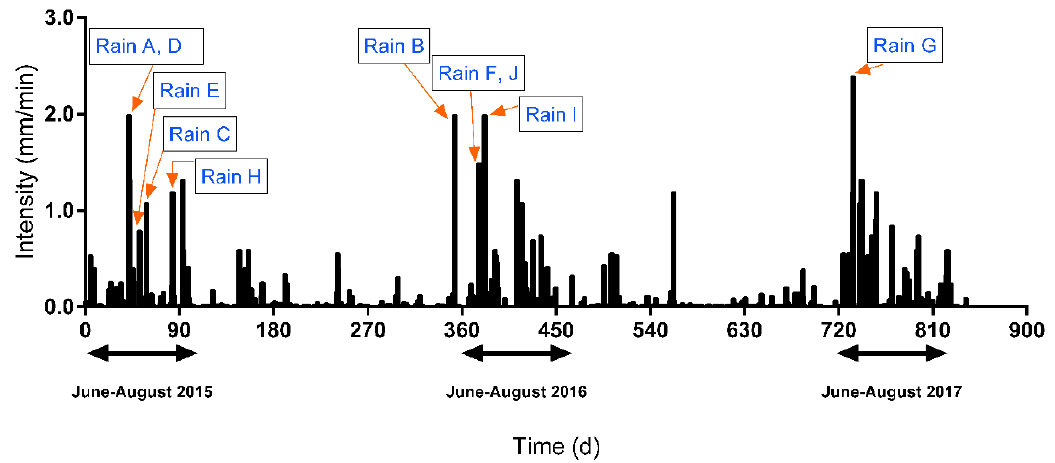
Figure 3. Hyetograph over the period of the study.